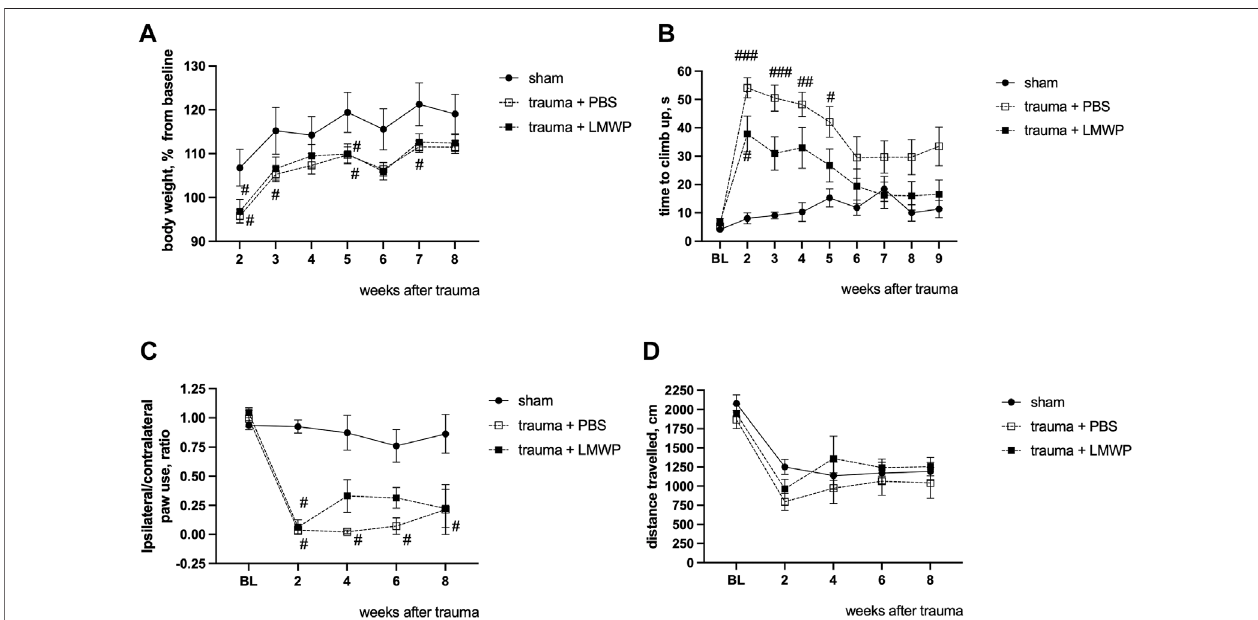
FIGURE 7 | Functional outcomes of ICV-delivered LMWP treatment in the mouse cervical hemicontusion model. (A) There are no differences in normalized body weight between the LMWP- and PBS-treated groups during the period of follow-up behavioral testing from the week 2 to the week 8. # p < 0.05, one-way ANOVA with post-hocTukey ’ spair-wisecomparisonversusshamgroup, n =6 – 11. (B) MicetreatedwithLMWPprogressivelyimprovetheclimbingfunctionintheverticalscreentest starting from the week 3 after the trauma induction. (C) The LMWP-treated animals demonstrate reduction in front paw use asymmetry starting from the week 4 afterthetrauma. (B,C) # p < 0.05, ### p < 0.001Kruskal-WallistestwithDunn ’ spost-hocpair-wise comparisonversustheshamgroup; n =6 – 11. (D) Generallocomotor activity for 15 min in the open fi eld chamber is quite similar for all animal groups.